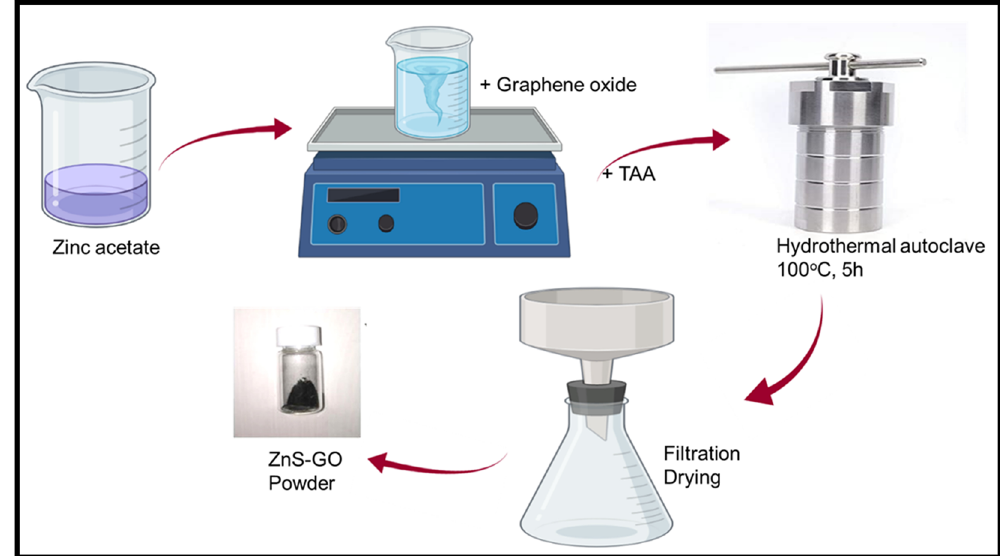
Figure 22: Schematic of the GOZS synthesis procedure starting from GO with the addition of zinc compound, followed by the heating and fi ltration to fi nally produce the composite in black colored